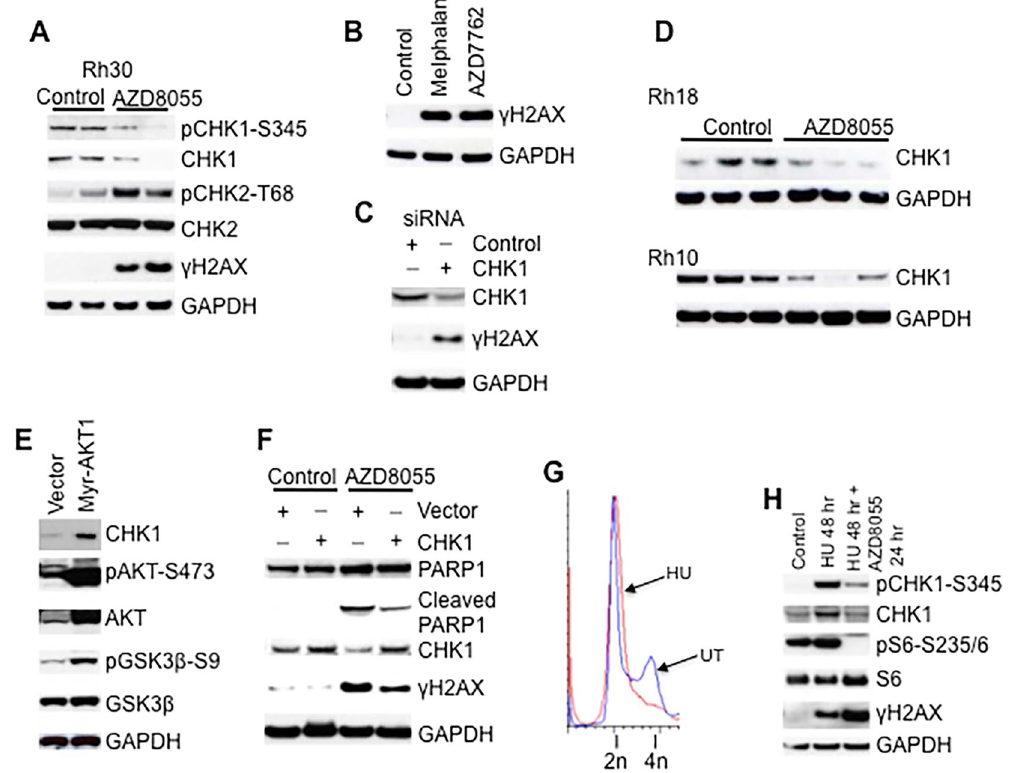
Figure 2. Inhibition of mTOR Signaling Impairs CHK1 DNA Replication Checkpoint. ( A ) Protein extracts of Rh30 tumor xenografts treated with vehicle or AZD8055 were used for immunoblotting. Two tumors were randomly picked for each group. ( B ) Rh30 cells were treated with CHK1 kinase inhibitor AZD7762 (1 μ M) or melphalan (10 μ g/mL) for 5 hr. Immunblotting was done to determine γ H2AX. ( C ) Rh30 cells were transfected with control or CHK1 siRNA. 48 hr later, total proteins were extracted for immunoblotting of γ H2AX and CHK1. ( D ), As in Fig. 2A, CHK1 antibody were used to determine the total protein levels of CHK1 in Rh18 and Rh10 tumor xenograft models treated with AZD8055. ( E ) Rh30 cells were transfected with vector or Myr-AKT1 plasmid. 48 hr later, total proteins were extracted for immunoblotting. ( F ) Rh30 cells were transfected with vector or CHK1 plasmid. 24 hr later, AZD8055 was added for additional 24 hr. Total proteins were extracted for immunoblotting. ( G ) Rh30 cells were treated with hydroxyurea (HU) at 2 mM for 24 hr to induce S-phase arrest. Flow cytometry was performed to show the early S phase arrest by HU and compared to untreated (UT) cells. 2n, diploid DNA; 4n, tetraploid DNA. ( H ) Rh30 cells were treated with HU at 2 mM for 24 hr, AZD8055 (1 μ M) was added for additional 24 hr. pCHK1-S345, CHK1, S6, pS6-235/6 and γ H2AX antibodies were applied for immunoblotting. Control, without treatment; HU 48 hr, cells treated for 48 hr; HU 48 hr + AZD8055 24 hr, cells treated with HU for 48 hr and AZD8055 for 24 hr in the presence of HU. GAPDH served as loading controls. Immunoblots were converted to gray with auto tone by Photoshop